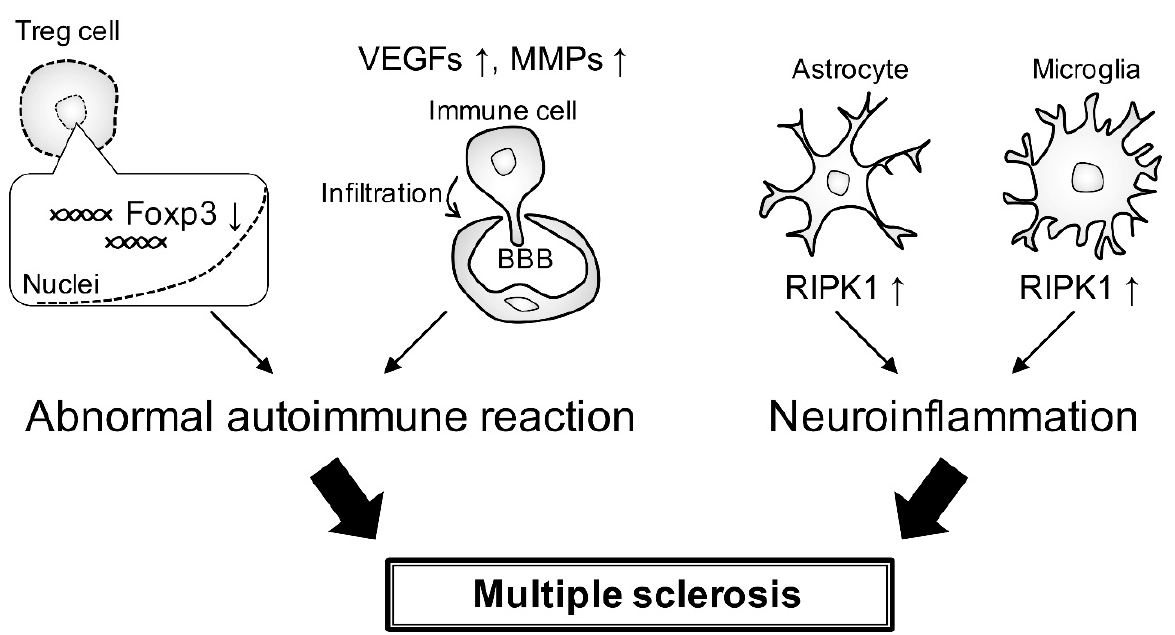
Figure 4. Abnormal autoimmune reaction and neuroinflammation in MS. Altered Foxp3 expres- sion in Treg cells induces an abnormal autoimmune reaction. Expression levels of vascular endothelial growth factors and matrix metallopeptidases are increased, probably disrupting the blood–brain barrier. This disruption allows immune cells to infiltrate. Phosphorylation of RIPK1 in astrocytes and microglia is involved in the promotion of the neuroinflammatory